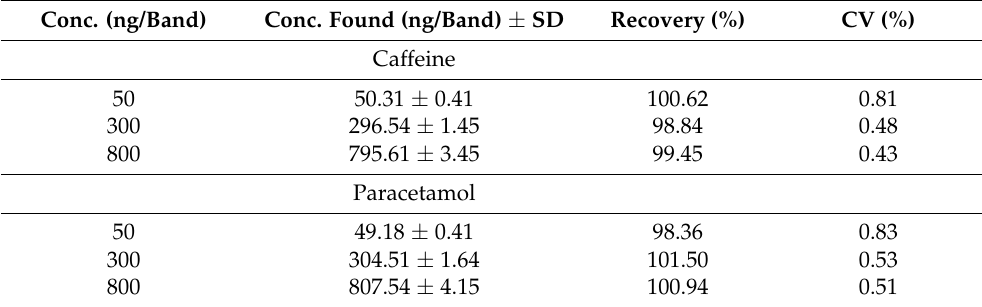
Table 6. Measurement of the accuracy of caffeine and paracetamol for the greener reversed-phase HPTLC method (mean ± SD; n = 6).